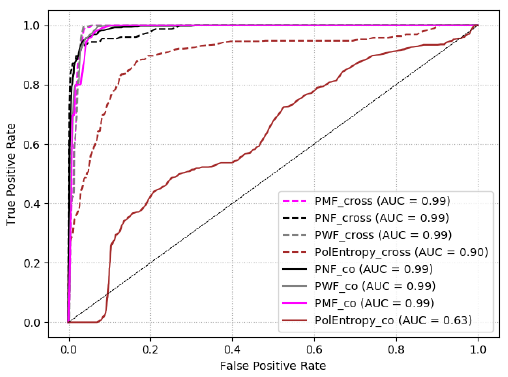
Figure 8. Comparing polarimetric modes: ROC curves for dual co-pol and cross-pol data in SM mode (pixel-based,